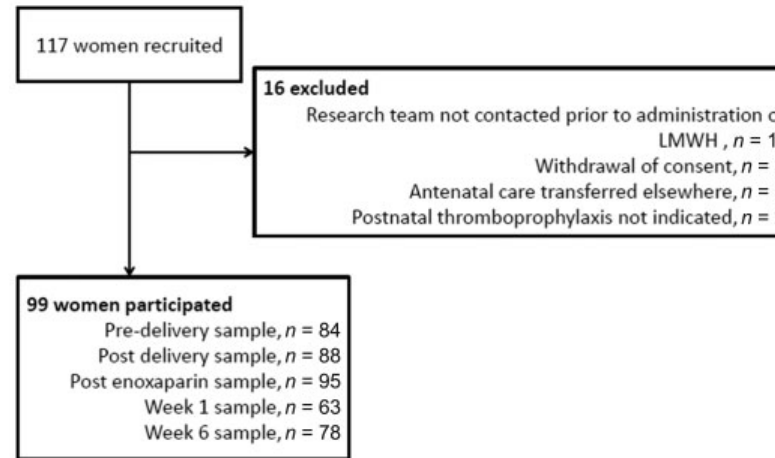
Fig. 1 Study fl ow